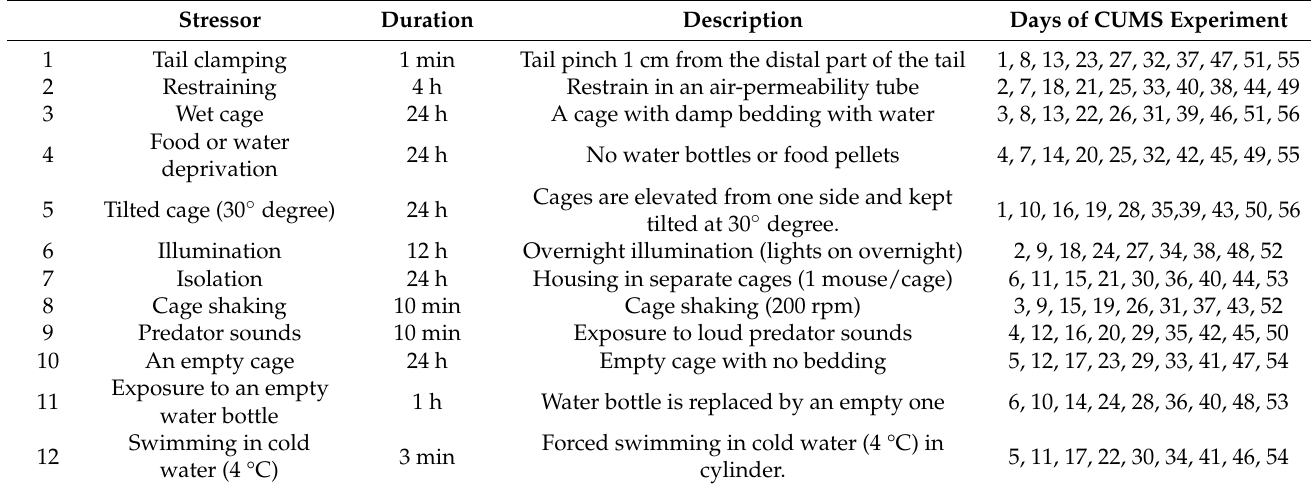
Table 1. Stressors used in the Chronic Unpredictable Mild Stress (CUMS)